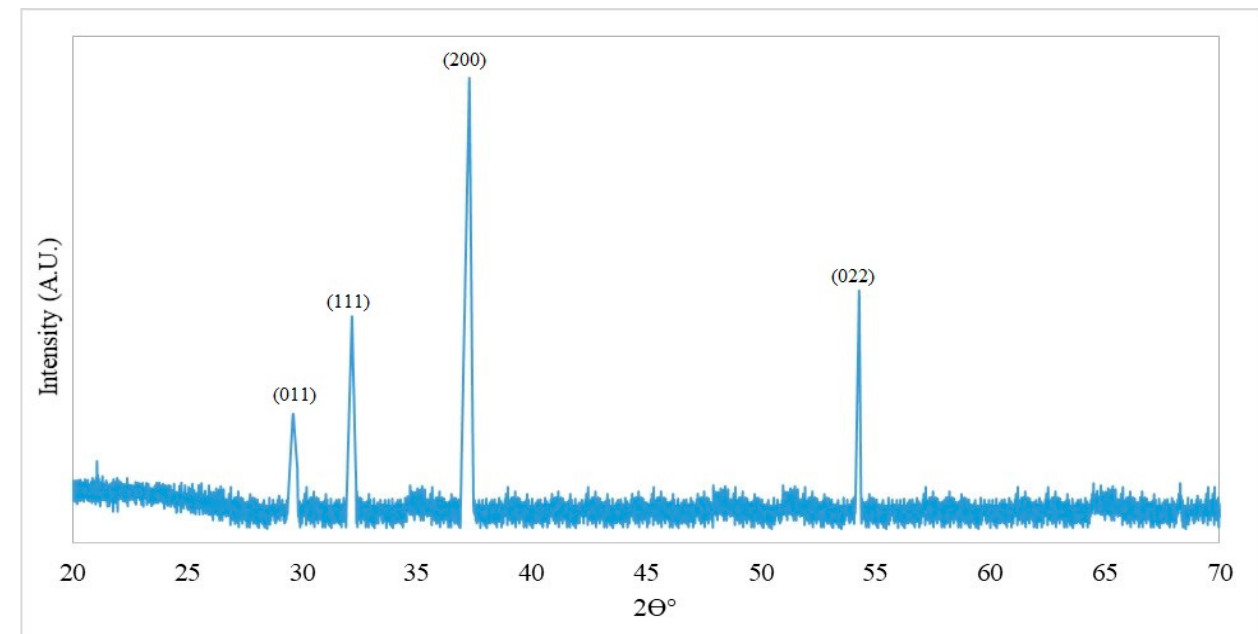
Figure 3. The X-ray di ff raction (XRD) spectrograph of calcium oxide nanoparticles.